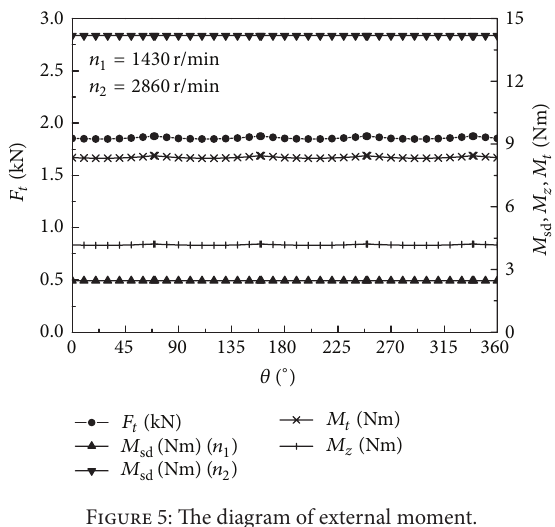
Figure 5: The diagram of external moment.